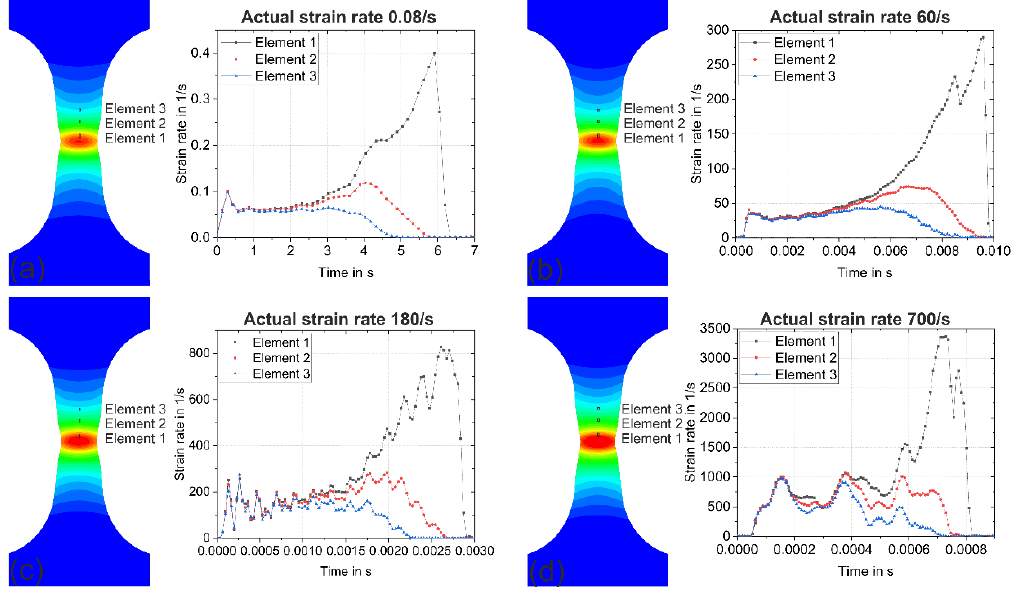
Figure 11. Comparison of strain rate values for individual elements obtained from process simulations for actual strain rates of 0.08/s ( a ), 60/s ( b ), 180/s ( c ), and 700/s ( d ).